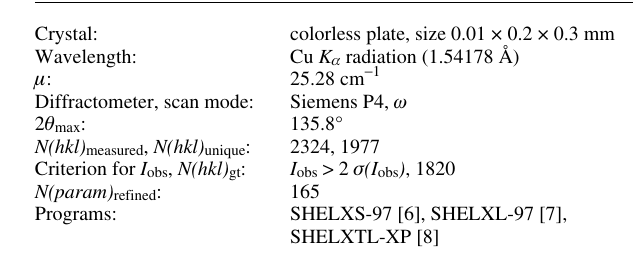
Table 1. Data collection and handling.